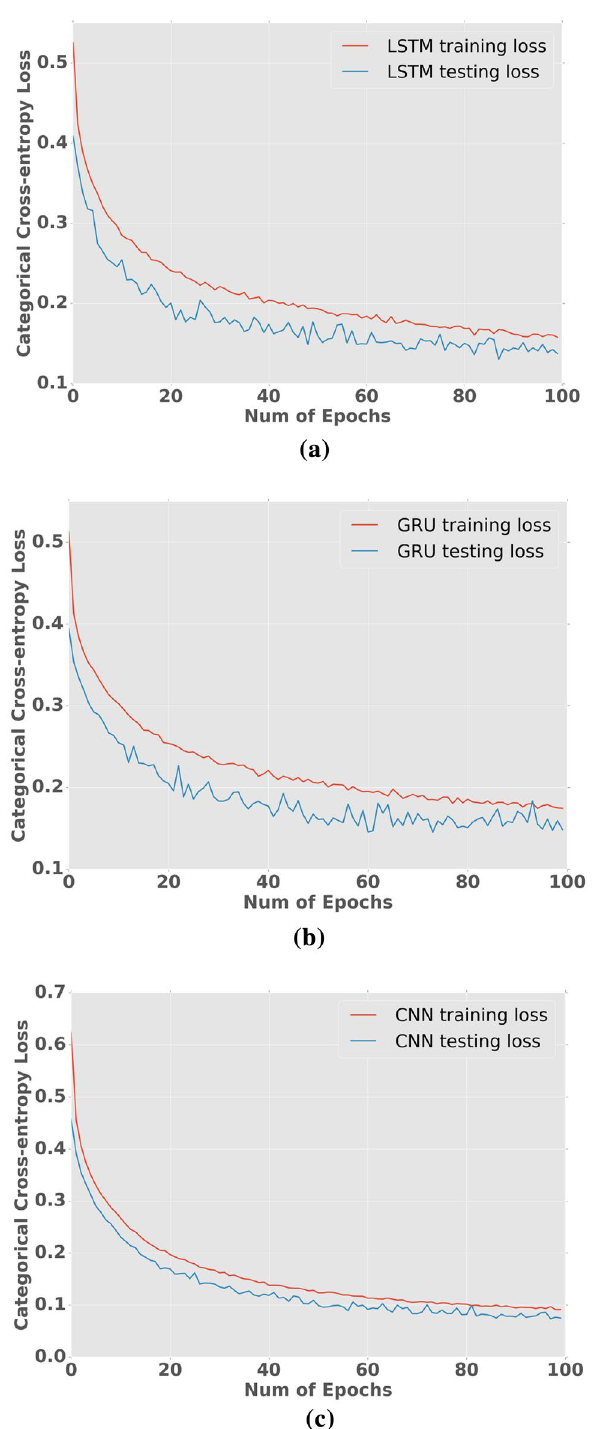
Fig. 10 a Categorical cross-entropy loss function curves for LSTM architectures calculated using Eq. (17). b Categorical cross-entropy loss function curves for GRU architectures calculated using Eq. (17). c Categorical cross-entropy loss function curves for CNN architec- tures calculated using Eq.